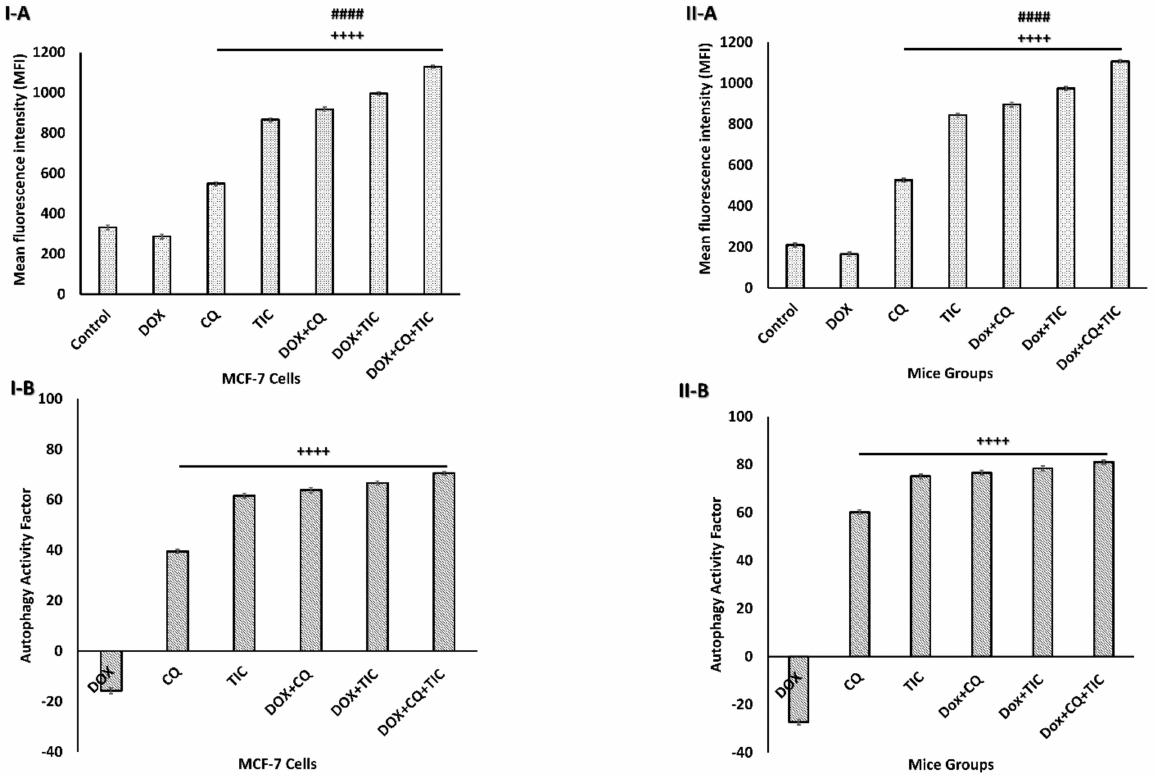
Figure 5. Autophagic flux blockage induces autophagosome accumulation. Bar diagram showing mean fluorescence intensity (MFI) of autophagosome marker in MCF-7 cells ( I-A ) and MCF-7 Xenograft mice ( II-A ) treated with single or combinatorial treatments that induced autophagic cell death, which was investigated by flow cytometry analysis. Bar diagram showing relative flow cytometry level (%) representing Autophagy Activity Factor (AAF) of MCF-7 cells ( I-B ) and MCF-7 tumor-bearing mice ( II-B ) treated with single or combinatorial treatments. Each value expressed as mean ± SE, ( n = 3). # p < 0.05, ## p < 0.01, ### p < 0.001, #### p < 0.0001 compared with control (untreated group). + p < 0.05, ++ p < 0.01, +++ p < 0.001, ++++ p < 0.0001 compared with the DOX treated